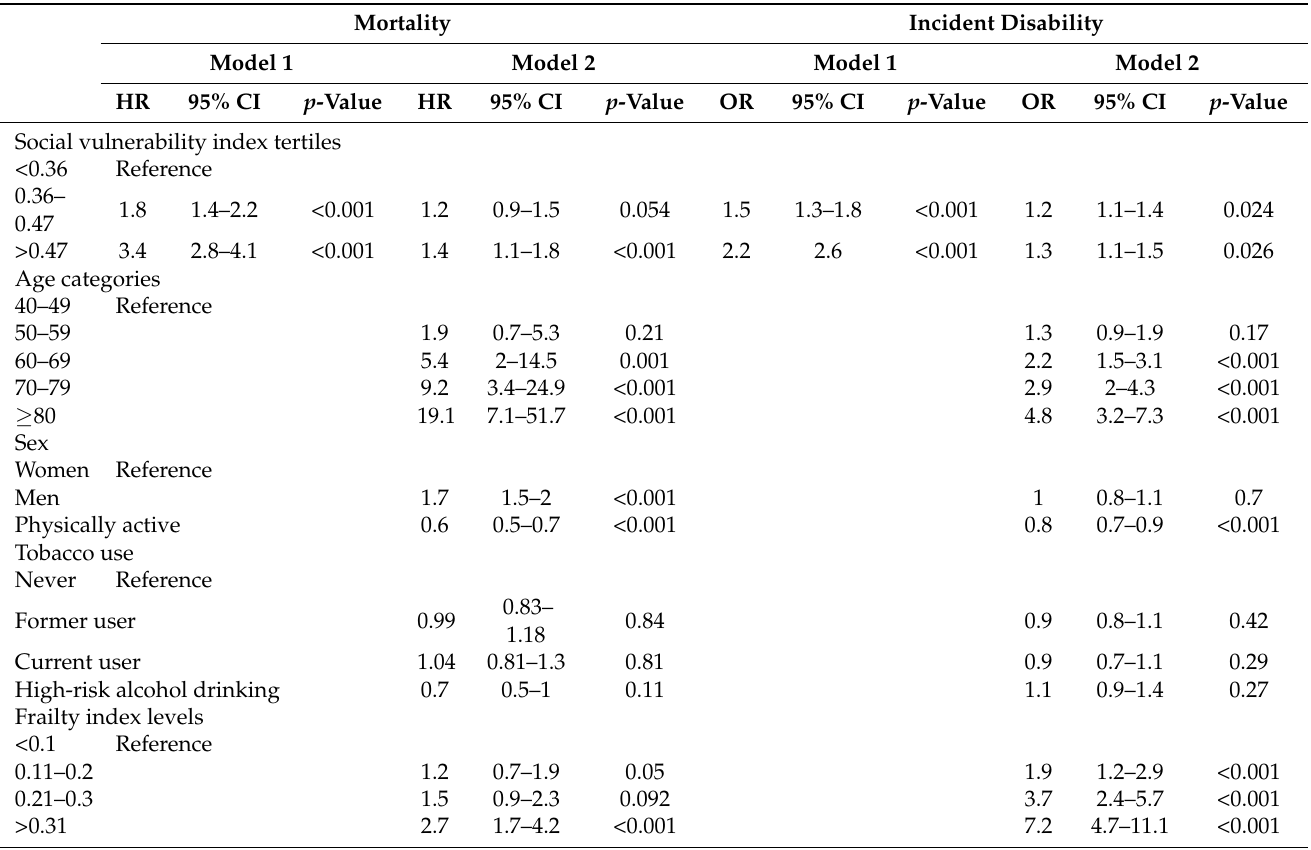
Table 4. Multivariate analysis of mortality and incident